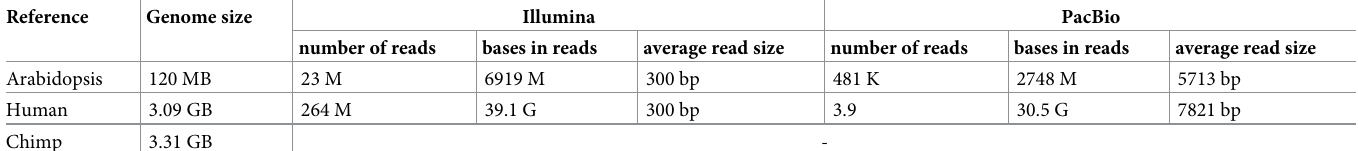
Table 17. Detailed description of the employed datasets for the genome-to-genome alignment, and the reads alignment with a reference sequence. In these compari- sons, the Illumina and PacBio data for Arabidopsis thaliana Ler-0 genome [68] are employed. Moreover, the human Illumina and PacBio reads are employed from the Ash- kenazi child data set, which is available from the Genome in a Bottle project [69], NCBI SRA accession SRX847862. Furthermore, the reference genomes are the Arabidopsis thaliana Col-0 reference genome [62], human reference genome versionGRCH38.p7 [63], and the chimpanzee (pan troglodytes) genome [70], released in Pan- Tro4, GenBank accession